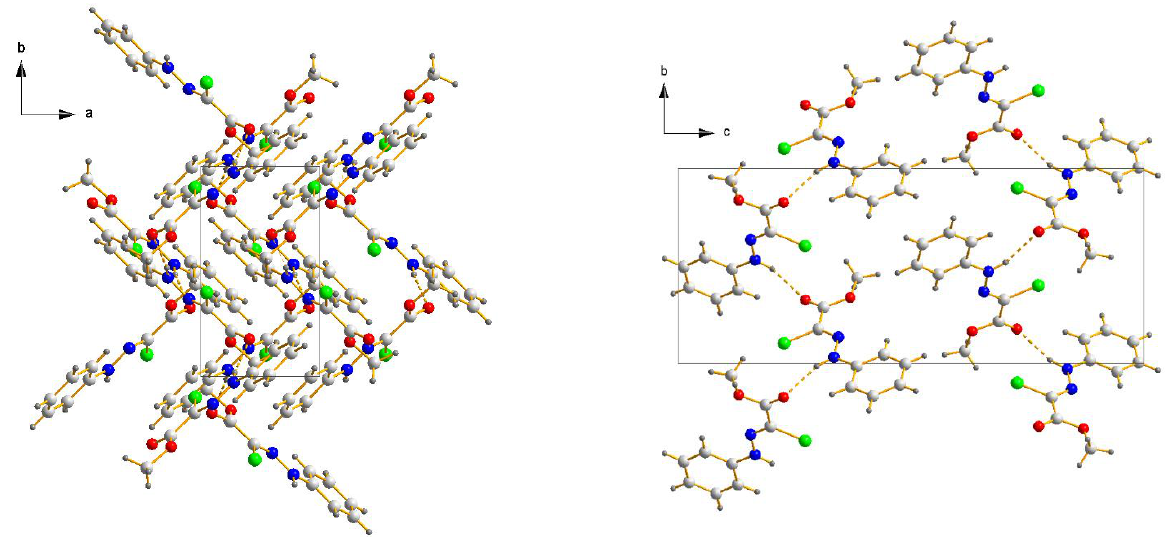
Figure 4. Crystal packing views down the c ( left ) and a ( right ) axis for compound 1 .